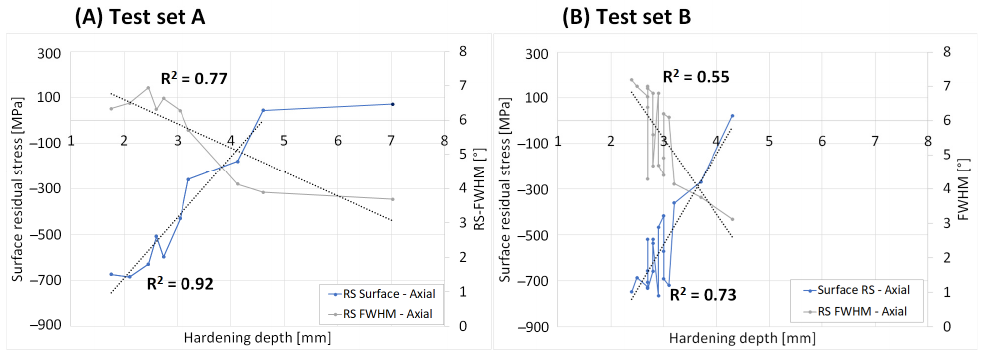
Figure 5. Surface residuals stresses versus the hardening depth for ( A ) set A and ( B ) set B.